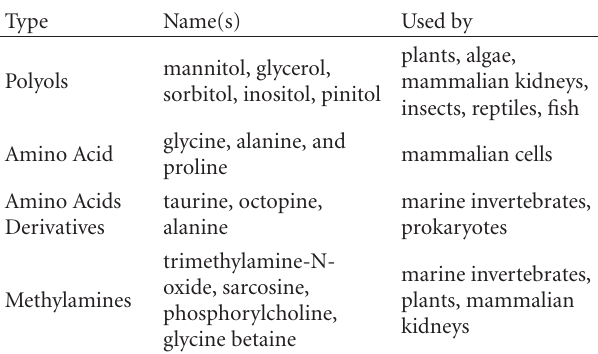
Table 1: List of some known naturally occurring osmolytes in each class with their major presence in protecting the stability of specific proteins under harsh